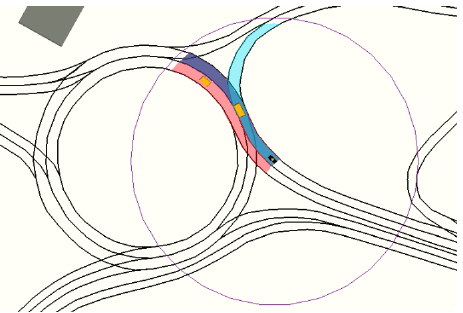
Figure 2. Navigation corridors for the black vehicle on a roundabout scenario. In this case, there are three possible corridors: two of them (blue and red) stay inside the roundabout, and a third one (cyan) takes the first exit to the right. The purple circle around the ego-vehicle represents the planning horizon for the corridors in this particular